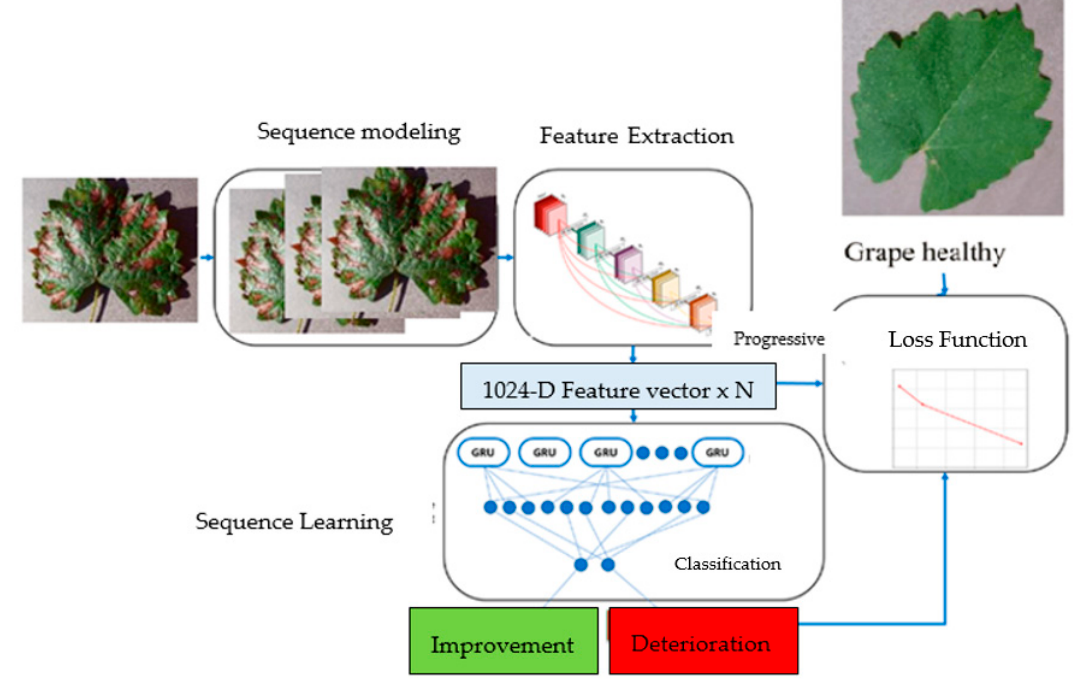
Figure 2. The flowchart of the proposed method.